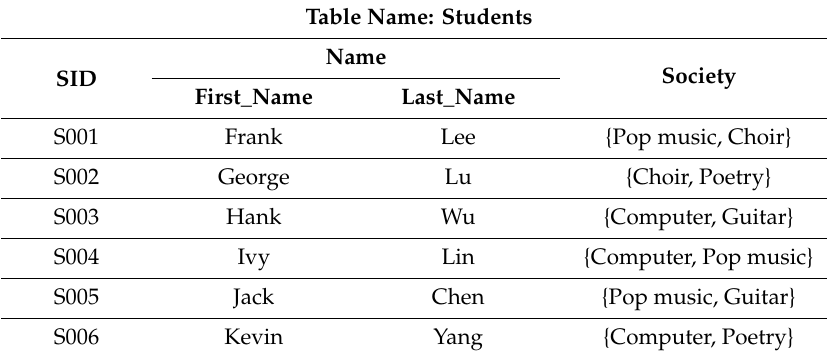
Table 4. An example of a data table in a multivalue database. Table Name: Students